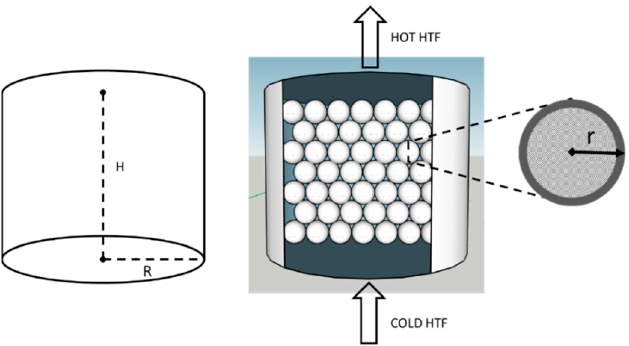
Figure 2. The heat exchanger unit geometry scheme used for the modelling.